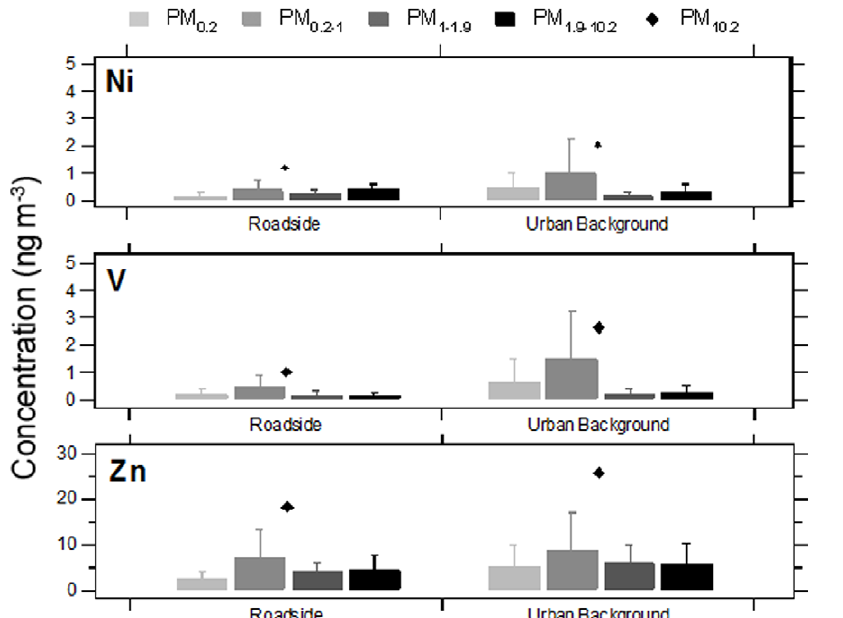
Figure 3. Mean size-fractionated PM trace metal (Ni, V, Zn) concentrations at primary school grouped by roadside and urban background site types. See the Figure 2 legend for a description of marker and statistical details.